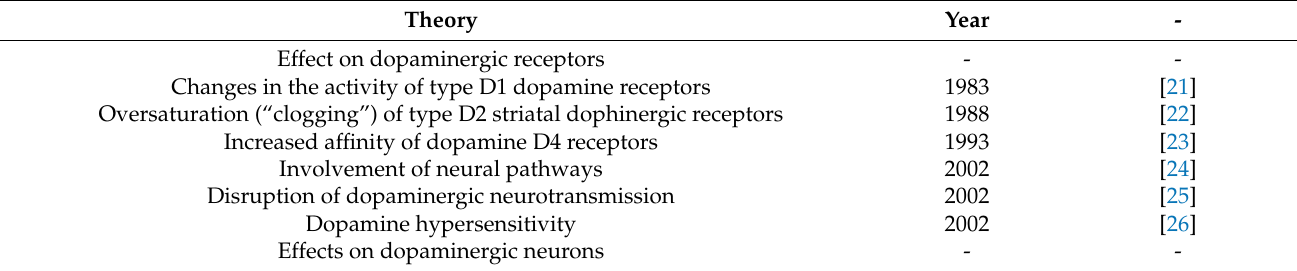
Table 2. Mechanisms of development of antipsychotic-induced tardive dyskinesia [7].